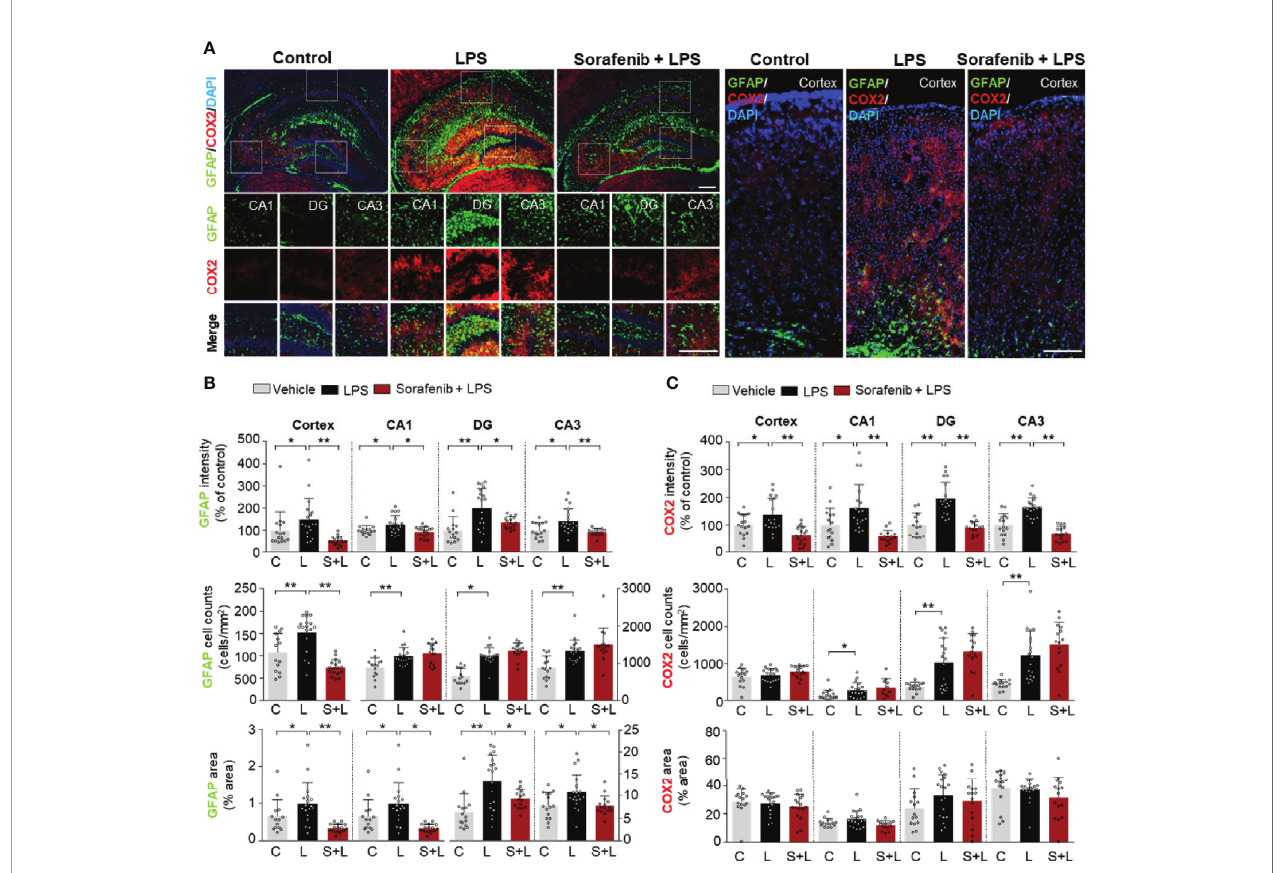
FIGURE 4 | Pretreatment of sorafenib suppresses LPS-induced astrogliosis and COX-2 levels in wild-type mice. (A) Immuno fl uorescence staining with anti-GFAP and anti-COX-2 antibodies of brain slices from wild-type mice treated with sorafenib followed by LPS. (B, C) Quanti fi cation of the data in (A) (analyzed number of brain slices/images (n); GFAP: Vehicle; n=16; LPS, n=18; Sorafenib + LPS, n=17, COX-2: Vehicle, n=16; LPS, n=18; Sorafenib + LPS, n=17). *p < 0.05, **p < 0.01, Scale bar = 200 m